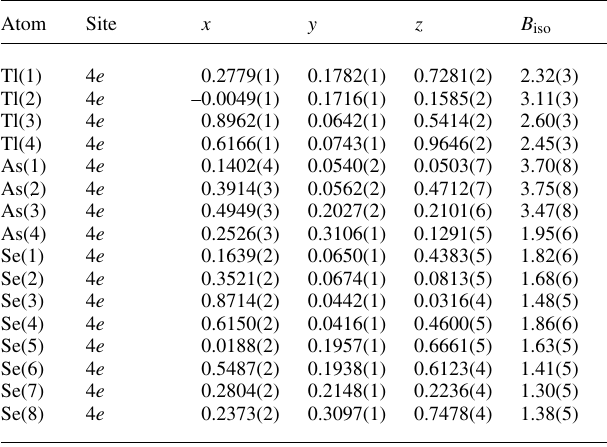
Table 2. Atomic coordinates and displacement parameters (in Å 2 )